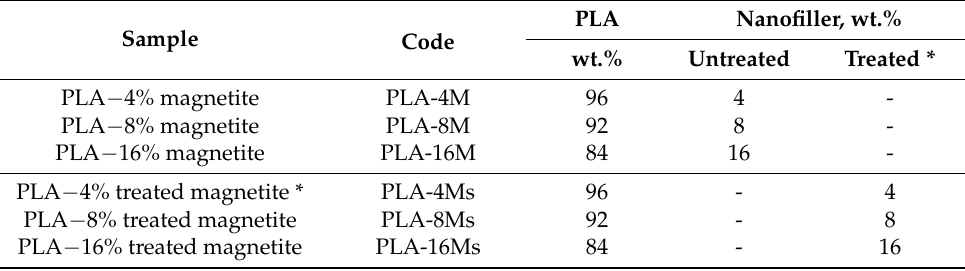
Table 1. Composition (wt.%) and codification of nanocomposite samples obtained by melt compounding. PLA Nanofiller, wt.% Sample Code wt.% Untreated Treated * PLA − 4% magnetite PLA-4M 96 - PLA − 8% magnetite